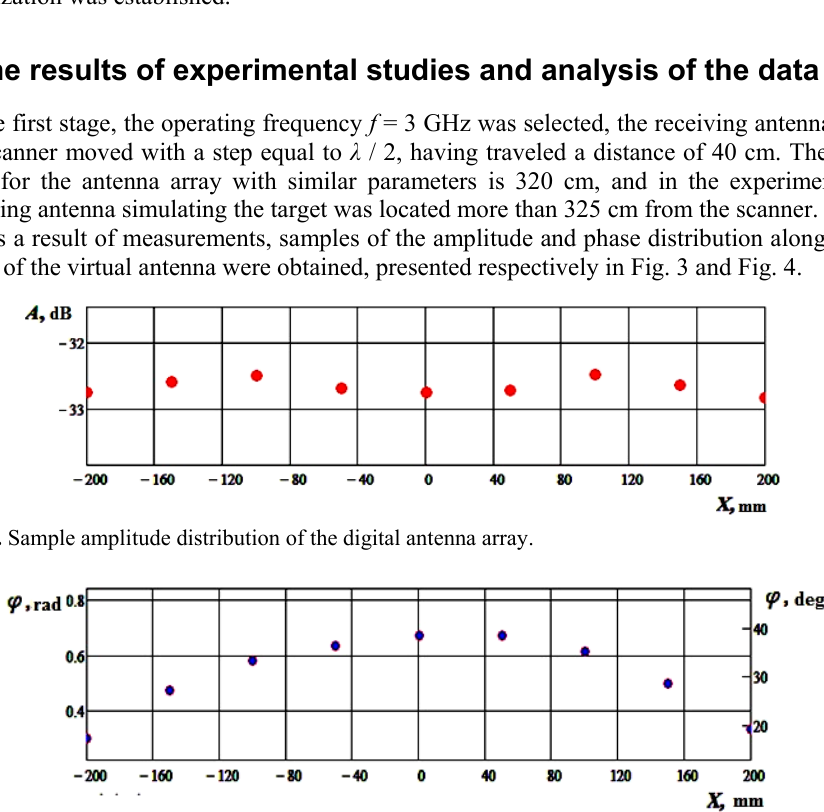
Fig. 4. Sample phase distribution of the digital antenna array.